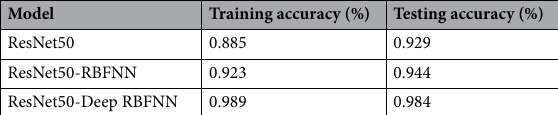
Table 5. Training and Testing Performance of the model.